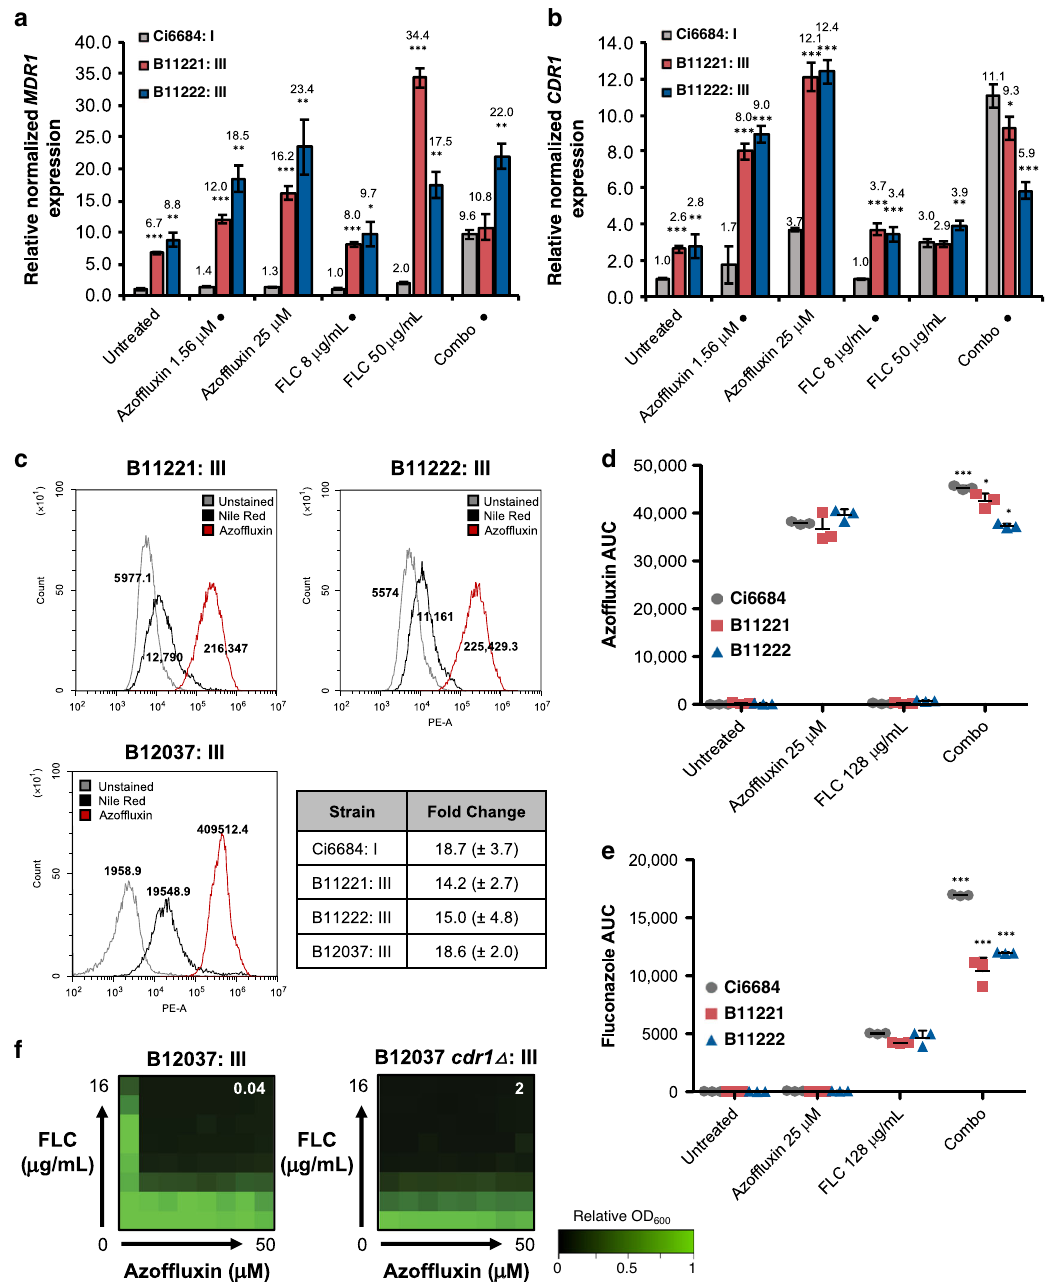
Fig. 5 Azof fl uxin does not potentiate fl uconazole (FLC) against most clade III isolates despite intracellular FLC accumulation and increased CDR1 expression. a Relative transcript levels of MDR1 (B9J08_003981) and b relative transcript levels of CDR1 (B9J08_000164) were measured in clade I isolate Ci6684 (gray) and clade III isolates B11221 (red) and B11222 (blue) ( (cid:129) indicates concentrations of FLC and azof fl uxin used in combination (combo) treatment). Data are presented as mean ± SEM of technical triplicates. A two-sided unpaired Student ’ s t test was performed to evaluate signi fi cance of differences between Ci6684 and each clade III isolate * p -value < 0.05, ** p -value < 0.01, and *** p -value < 0.001. c Flow cytometry was used to measure the Nile red accumulation in C. auris clade III strains as described in Fig. 2e. Values in histogram plots depict median fl uorescence intensity (MFI) and table shows the mean fold-change in MFI ± SD for biological triplicates. d The relative intracellular azof fl uxin abundance and e the relative intracellular FLC